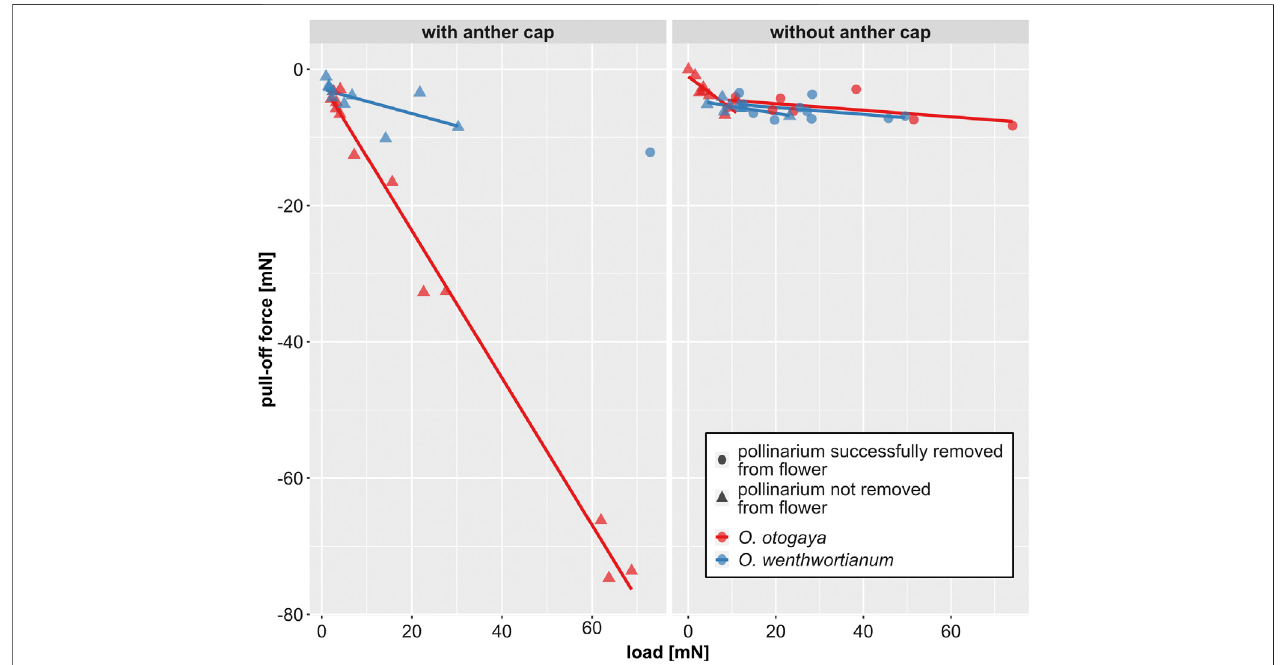
FIGURE5| Pull-offforcevs.load,measuredin Oncidiumotogaya and O.wentworthianum fl owerswith(left)andwithoutanthercap(right)andgroupedbyspecies (color of the symbol) and success of pollinarium removal (shape of the symbol). Statistical details for the linear regression lines are displayed in Table 1 .